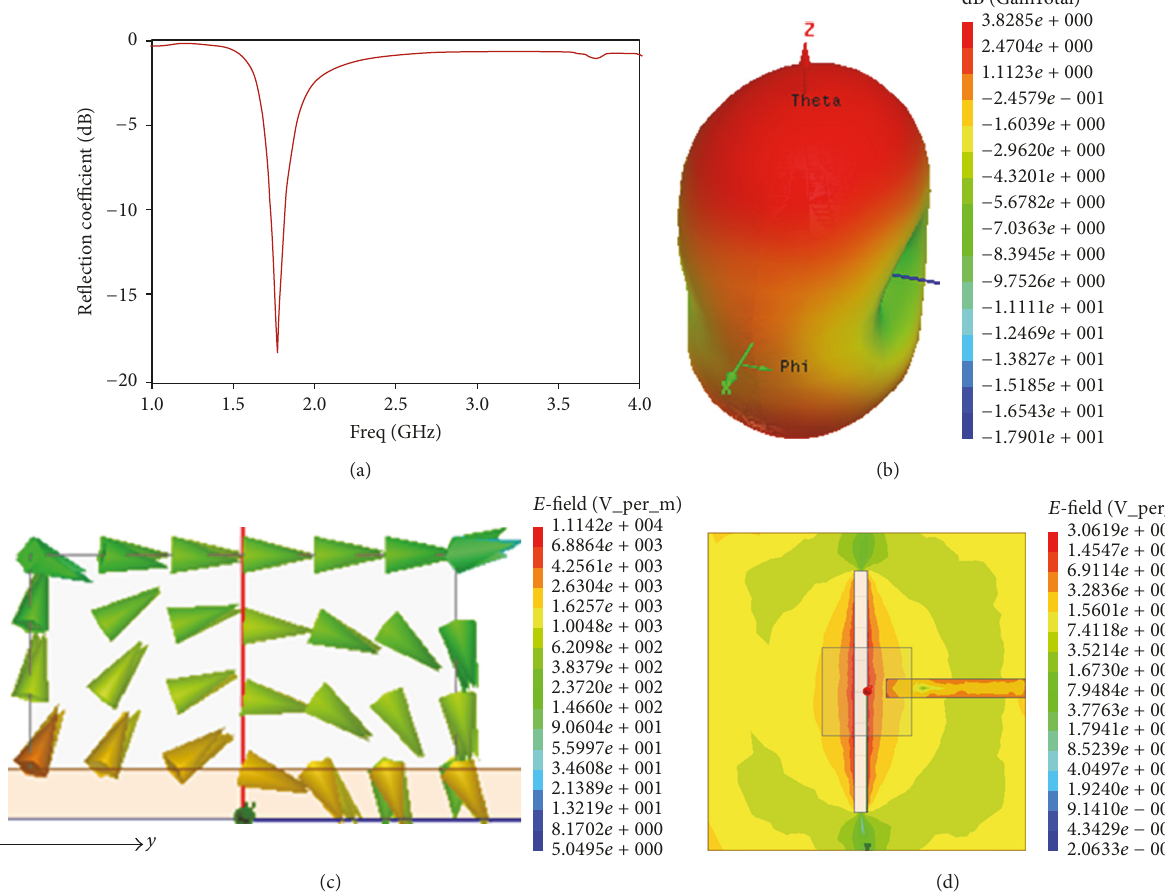
Figure 6: Antenna parameters in presence of slot. (a) Reflection coefficient, (b) 3D gain plot, (c) 𝐸 -field distribution on DRA at 1.77 GHz, and (d) surface current distribution on ground plane at 1.77 GHz. Table 2: Comparison between DRAs with proposed structure on the basis of compactness. S.